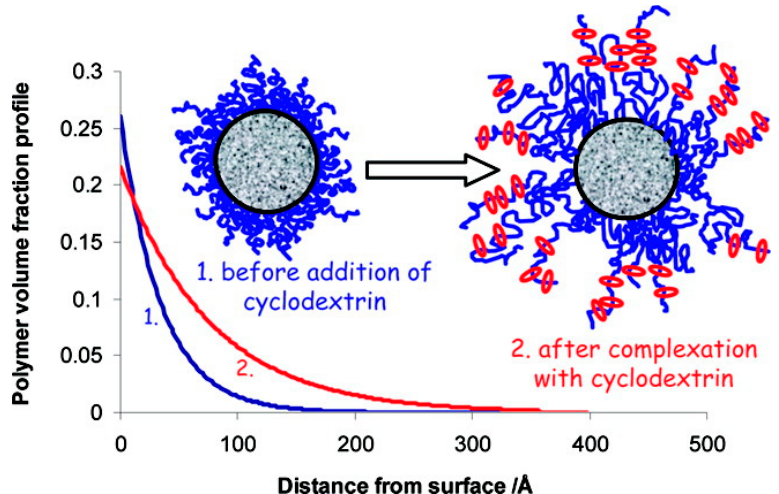
Figure 7. Plot presenting the effect of adding α -CD on the polymer volume profile. Adapted with permission from Langmuir 2008 , 24 , 10005–10010 [149]. Copyright (2008) American Chemical Society.